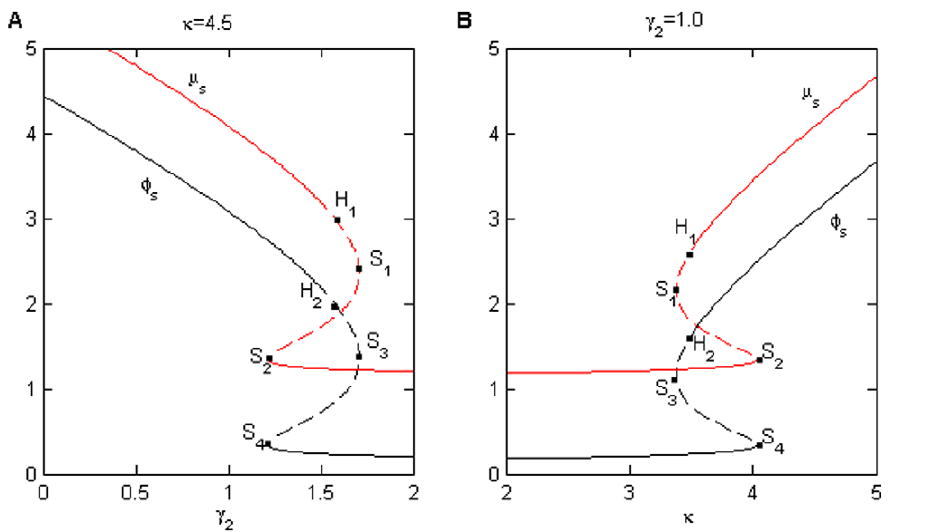
Figure 4. The steady-state bifurcation diagrams of the protein concentration w (black line) and miRNA concentration m (red line) for (A) k ~ 4 : 5 and (B) c 2 ~ 1 : 0 with increasing c 2 and k , respectively. S 1 = S 2 = S 3 = S 4 denote saddle points and H 1 = H 2 represent a Hopf bifurcations. Clearly, the system has completed the transitions (A) from monostability to bistability to excitability, and has finally transitioned to monostability with increasing c 2 or (B) from monostability to excitability to bistability, and has finally transitioned to monostability with increasing k . The parameter values are a ~ 0 : 15 , c 1 ~ 1 : 0 , c 2 ~ 1 : 0 , and e ~ 0 : 05